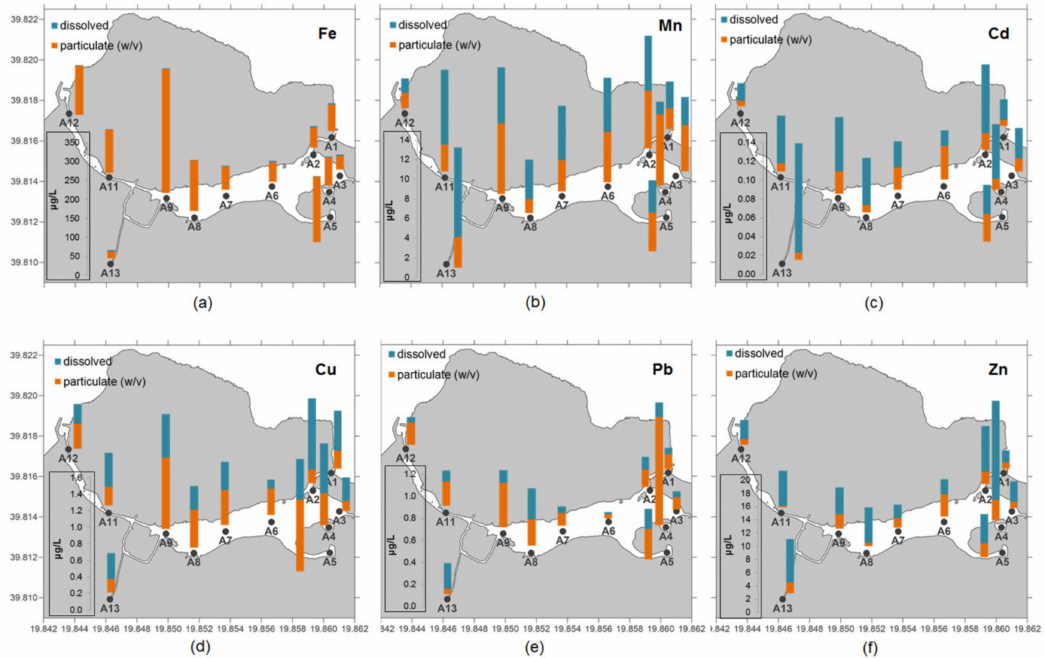
Figure 2. Spatial variation of dissolved and particulate (w / v) concentrations for ( a ) Fe, ( b ) Mn, ( c ) Cd, ( d ) Cu, ( e ) Pb, and ( f )